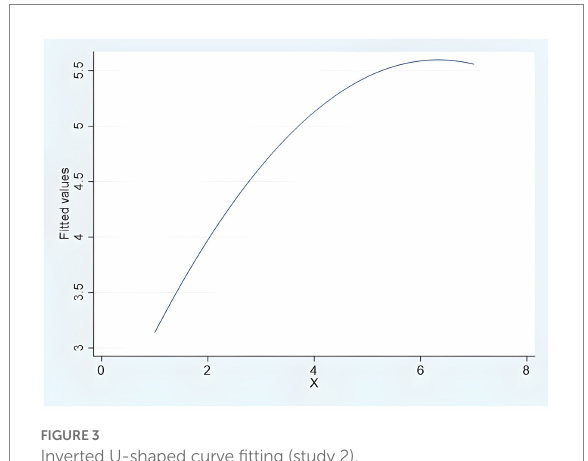
FIGURE 3 Inverted U-shaped curve fitting (study 2).